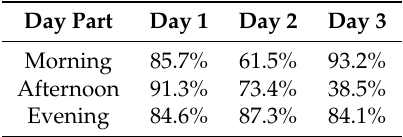
Table 1. Accuracy of the solution for each segment of the testing